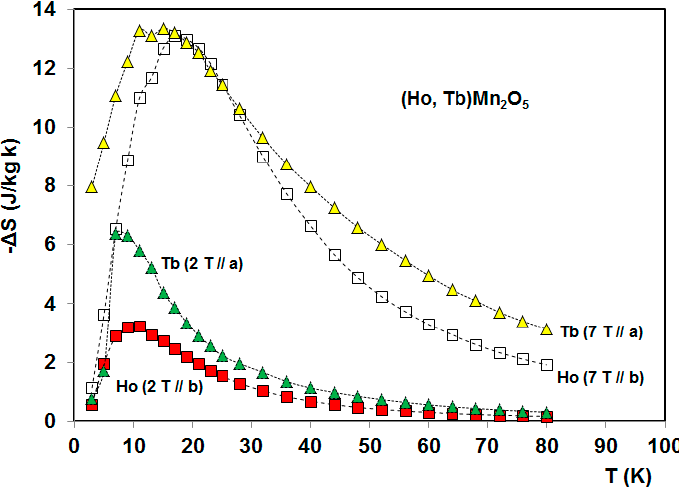
Figure 14. A comparison between entropy changes of RMn 2 O 5 (R = Ho and Tb) single crystals under relatively low (2 T) and high (7 T) magnetic fields applied along their easy-axes [19,20].